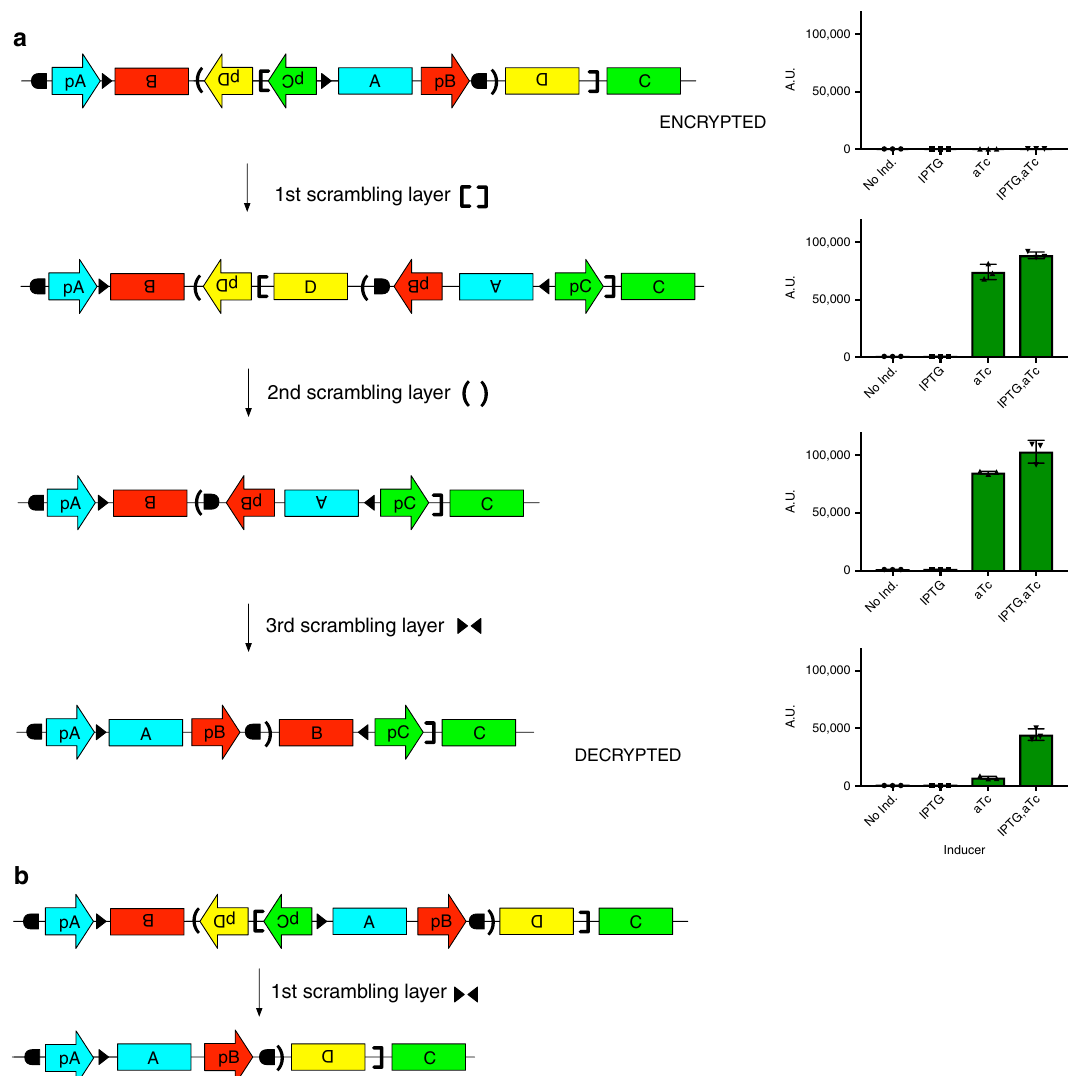
Fig. 2 Decryption of the genetic AND gate. a Unscrambling of the scrambled AND gate from Fig. 1. Behavior of constructs from each stage of the unscrambling is shown. N = 3, error bars represent standard deviation. The fi nal unscrambled construct (step 4) demonstrates AND gate behavior, whereas intermediate steps show non-AND gate behavior. b An example of an incorrect unscrambling. RiboJ sequences 34 were used directly upstream of the RBS of each gene to prevent any interference from the increased size of the 5 ′ UTRs (RiboJ54, RiboJ51, RiboJ53 and RiboJ, for araC , lacI , tetR , and gfp respectively). NoInd = no inducer, Arab =